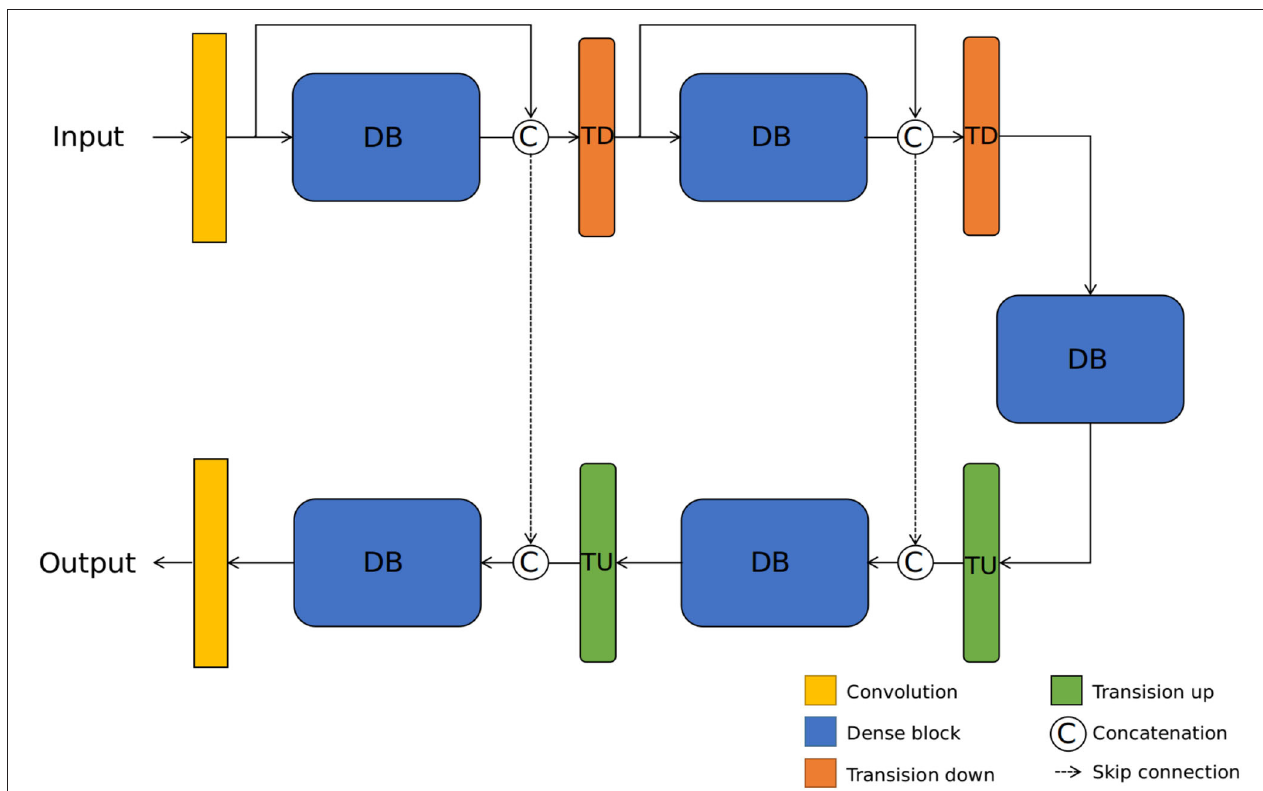
FIGURE A2 | The network architecture of the generator G d . Following the work of UW-Net (Gupta and Mitra, 2019), we choose DenseNet (Jégou et al., 2017) as the generator G d